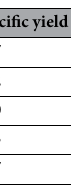
Table 2. The measured specific yield for different